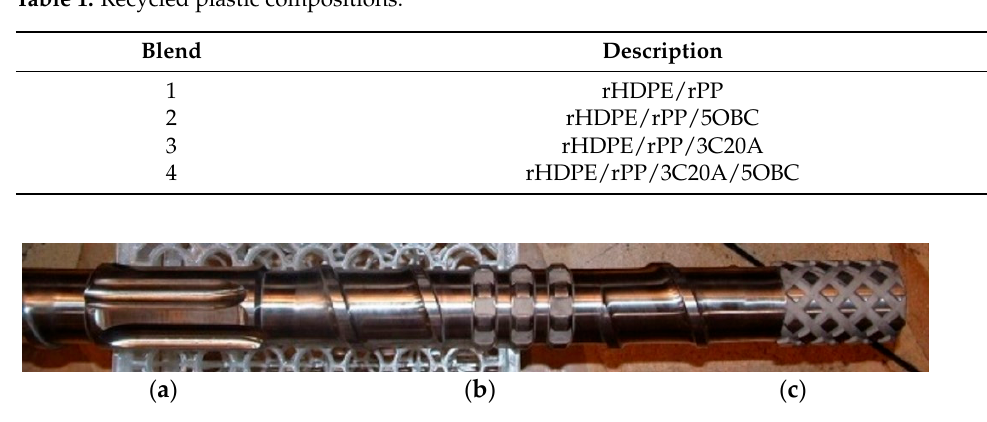
Figure 2. From the end of the screw: ( a ) dispersive mixer (Maddock) and distributive mixers ( b ) Rings, and ( c ) Pineapple in the screw design.